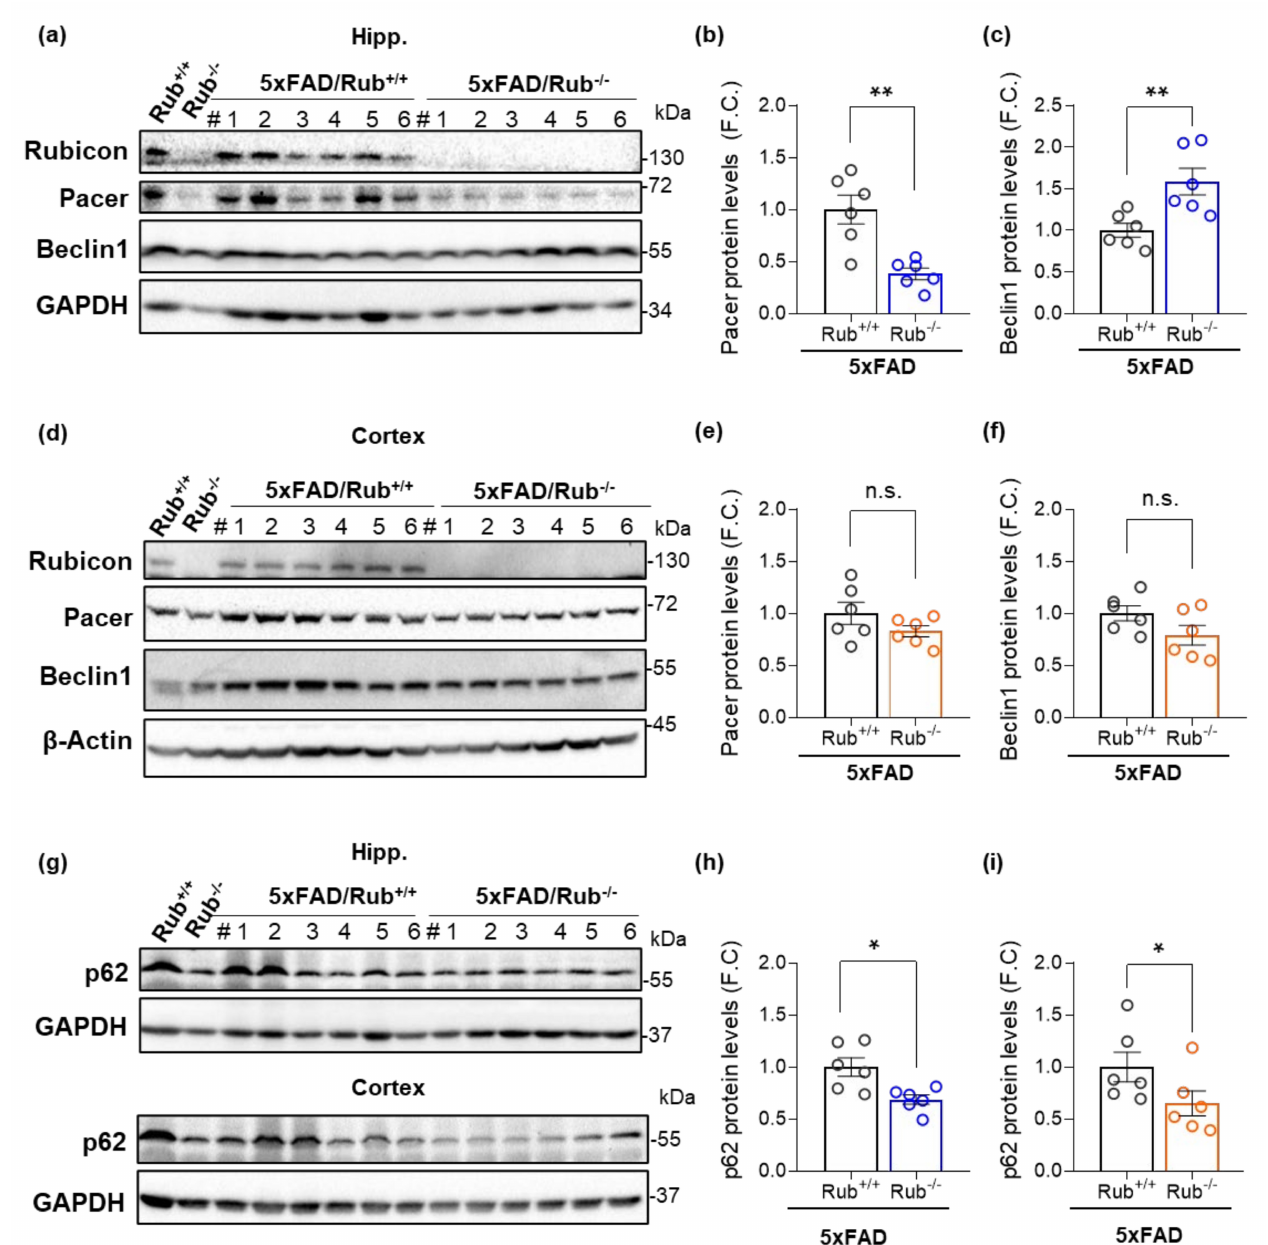
Figure 8. Autophagy markers in the hippocampus and cortex from 5xFAD lacking Rubicon. ( a – c ) Hippocampus; protein levels of Rubicon, Pacer, and Beclin1 were analyzed by Western blot in the hippocampus of mice with 5xFAD (5xFAD/Rub+/+) and 5xFAD lacking Rubicon (5xFAD/Rub − / − ) at six months of age; ( b , c ) Bar graphs indicate the quantitative densitometry of the Pacer protein ( b ) and Beclin1 ( c ). ( d – f ) Brain cortex; protein levels of Rubicon, Pacer, and Beclin1 in the cortex of the same mice. #, number of independent animals. ( e , f ) Bar graphs indicate the quantitative densitometry of the Pacer protein ( e ) and Beclin1 ( f ). ( g – i ) Protein levels of p62 were analyzed by Western blot in the hippocampus (( g ), upper panel) and in the cortex (( g ), lower panel) of mice with 5xFAD (5xFAD/Rub+/+) and 5xFAD lacking Rubicon (5xFAD/Rub − / − ) at six months of age; ( h , i ) Bar graphs indicate the quantitative densitometry of the p62 in the hippocampus ( h ) and cortex ( i ). β -Actin and GAPDH expression were monitored as loading controls. FC, fold change. Data are shown as means ± SEM ( n = 6). * p < 0.05; ** p < 0.01 as determined by the Mann-Whitney t -test, n.s., no